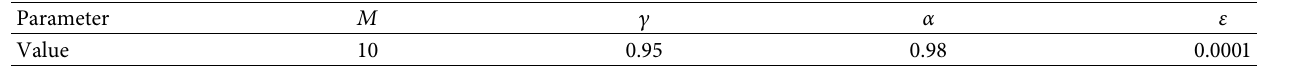
Table 4: Parameter values of the simulated annealing method.